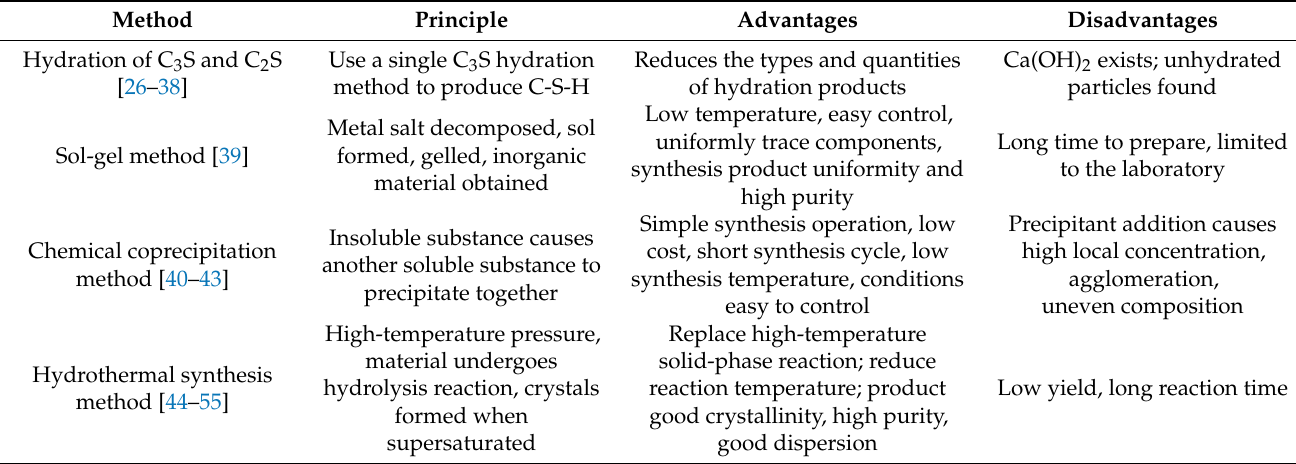
Table 1. Comparison of preparation methods of